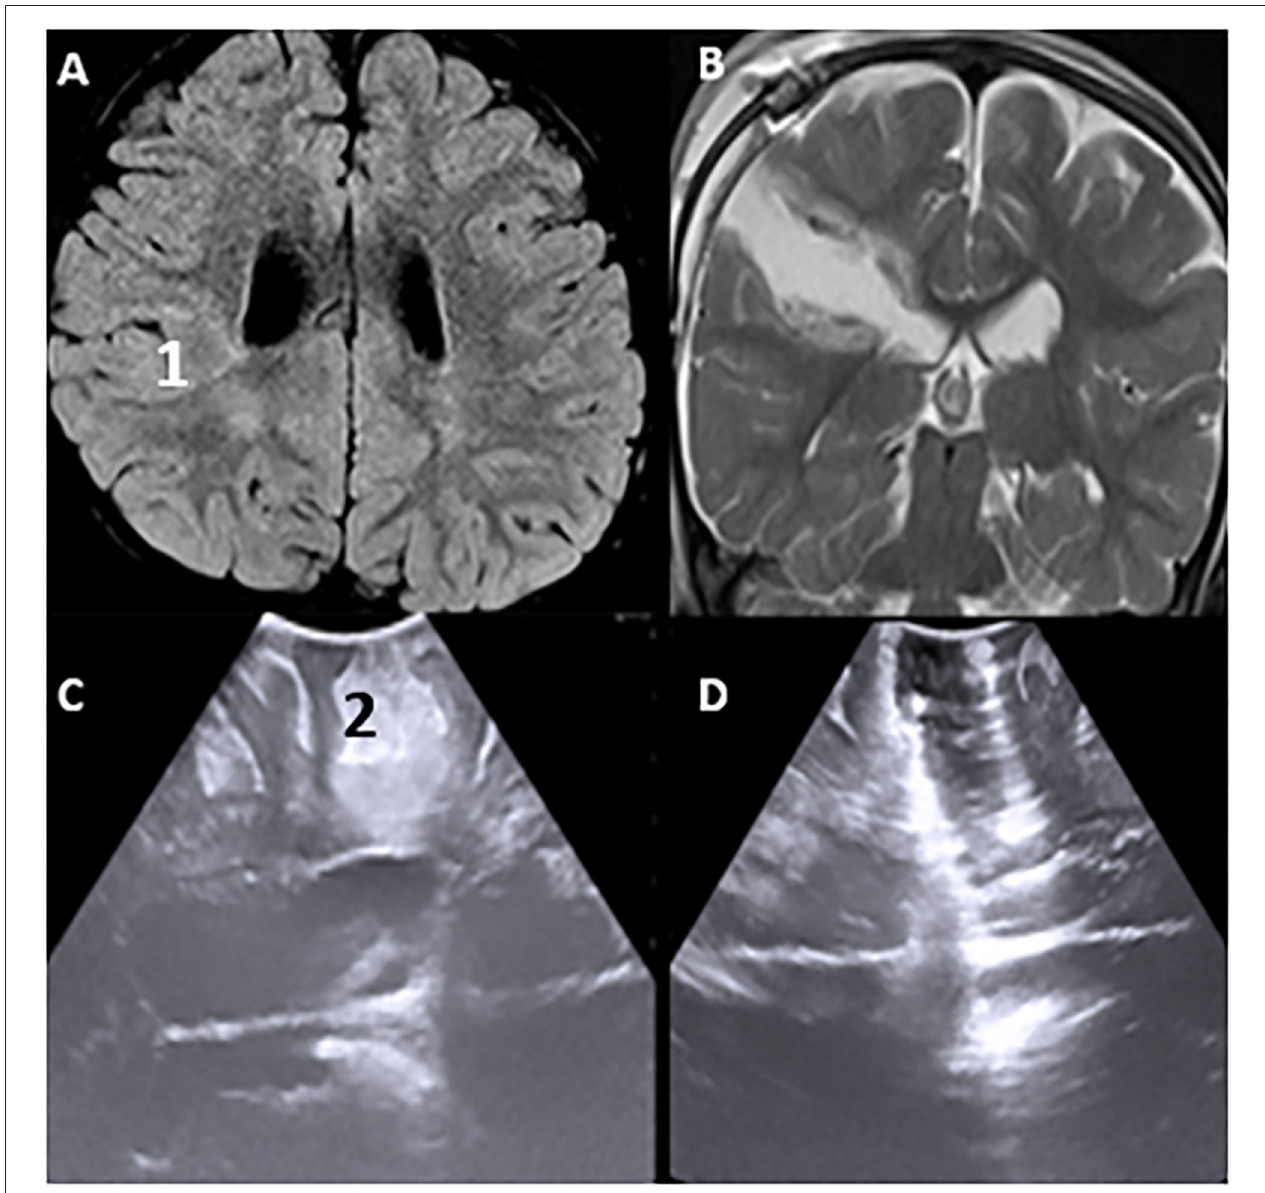
FIGURE 10 | Pre-operative Hyperintence axil MRI FLAIR rt FCD type IIb (A,1) in concordance with pre-resection intraoperative hyper echoic cortical and subcortical IUS features (C,2) . Post-operative coronal T2WI (B) and intraoperative post-resection IUS showing complete resection of the lesion (D)